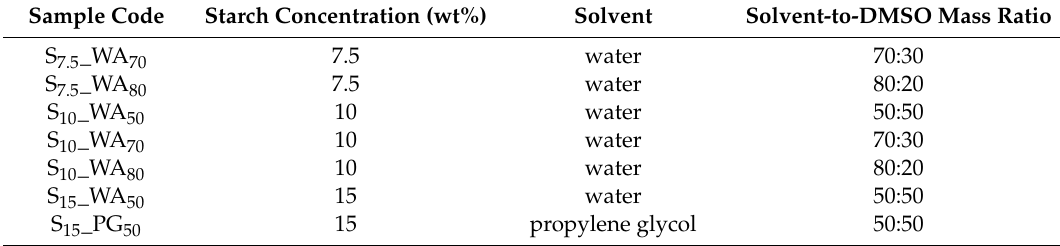
Table 2. Samples selected for aerogel production.